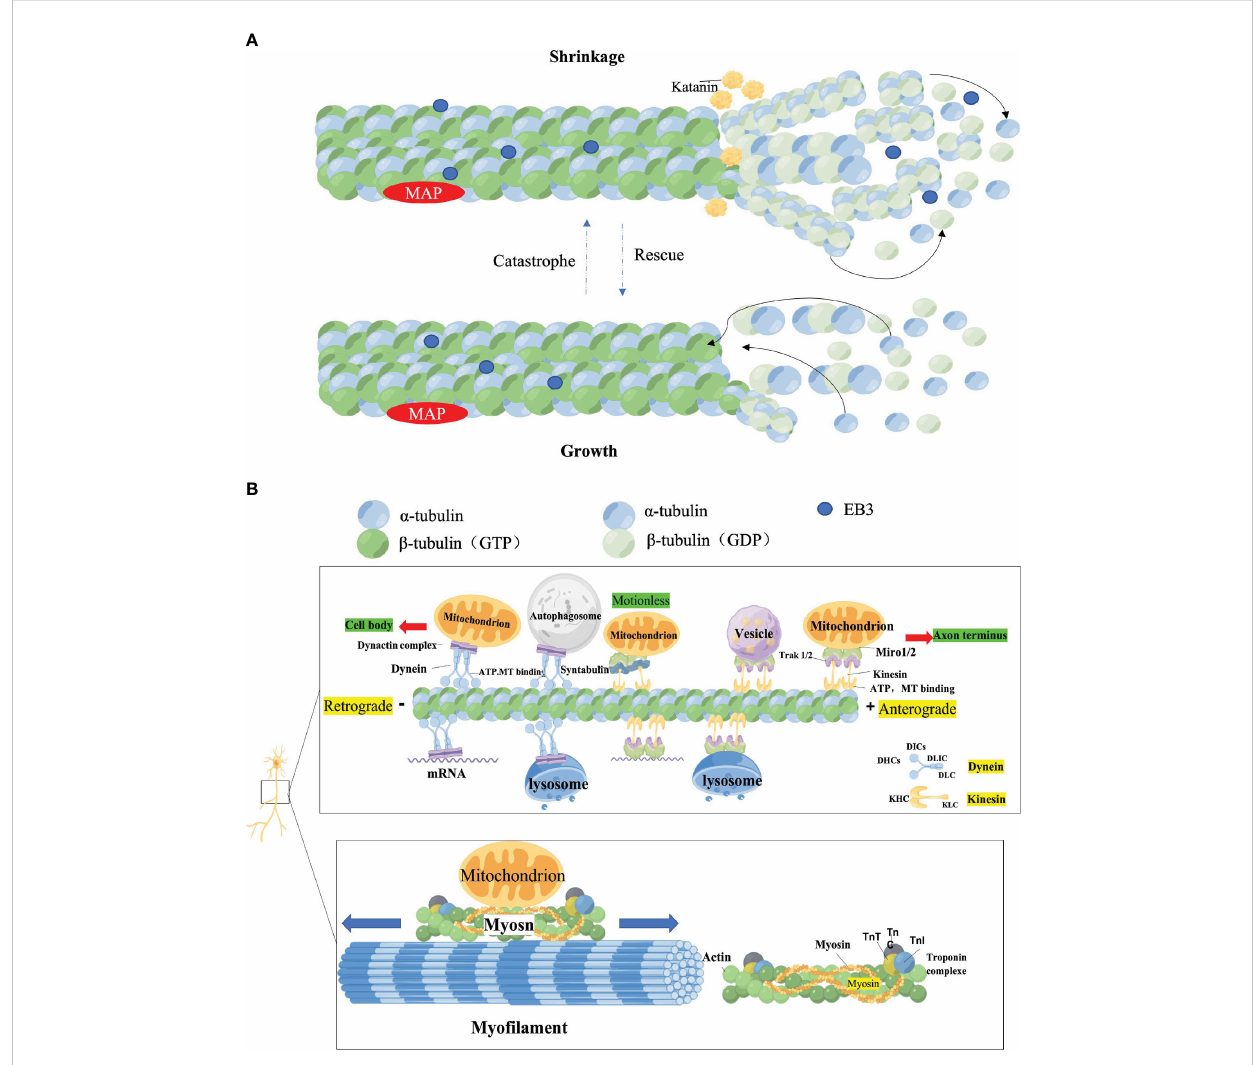
FIGURE 1 (A) Assembly of microtubules (MT). MTs are heterodimers of a -microtubulin and b -microtubulin, arranged radially with positive ends (positive end) facing the periphery and negative ends ( – end, negative-end) facing the cytosol. The microtubule-associated protein Katanin cuts off the centrosomal MTs, releasing small and dynamic MTs of different sizes that can be delivered to axons or exons. MTs can proceed concurrent cycles of convergence (growth) and depreciation (contraction) at their plus ends. Microtubule Associated Proteins (MAPs) EB protein, a microtubule- associated protein belonging to the MT plus end tracking protein (+TIPs), binds to EB3 and accumulates at the apex when MTs grow, and dissociates when growth stops or switches from growth to contraction (MTs become smaller). EB3 is also known to regulate microtubule dynamics during axonal outgrowth. (B) Axonal transport. Molecular motors, dependent MT and ATP, driven the long-distance transport Microtubules bind to motor proteins, which then link cargo through adaptor proteins to form a cargo transport complex, and the motor proteolysis of ATP provides energy to ensure a smooth process. The major components of molecular motors are Kinesin, Dynein, and Myosin. Kinesin directs the plus end, and Kinesin coordinates the anterograde transport of cargo (such as Vesicle) from the cell body to the axon end along microtubules. Kinesin includes two heavy (KHC) and two light (KLC) chains. The motor domain of KHC, with ATPase activity can bind directly to MTs, whereas its C-terminal domain Interact with KLC or interact with cargo. Dynein coordinates the retrograde transport of cargo such as autophagosomes from axon terminals to the cell body along microtubules. Dynein consists of two Dynein heavy chains (DHCs) and distinct intermediates (DICs), mild intermediates (DLIC), and light chains (DLC). It is mainly required to bind Dynactin (dynein-activating protein) to form the dynein-dynactin complex to bind cargo for axonal transport. In addition, mRNA, Lysosome, and mitochondrial were transported along the axon in both directions. Mitochondria can also use myosin motors for bidirectional transport over short distances along actin fi laments. Syntaphilin (SNPH) is a static anchoring protein of axon mitochondria. The MiRO1- TraK2 adaptor complex acts as an important regulator of neuronal cargo transport and increases mitochondrial motility by anchoring mitochondria to